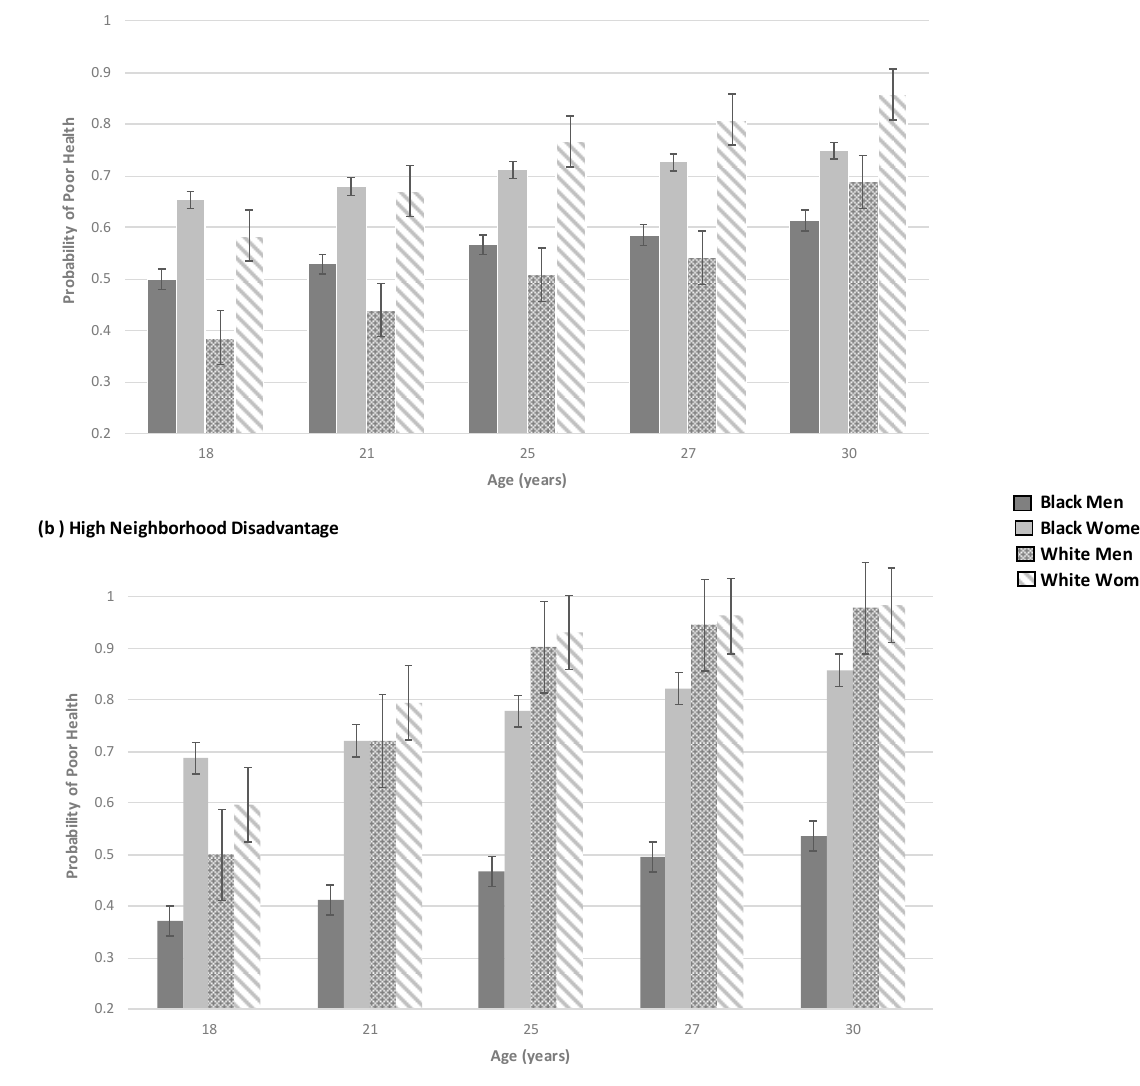
Figure 1. Relationship between poor health and race–gender status for those living in ( a ) low disadvantaged neighborhoods (bottom one-third) and ( b ) high disadvantaged neighborhoods (top one-third) at ages 18, 21, 25, 27, and 30.